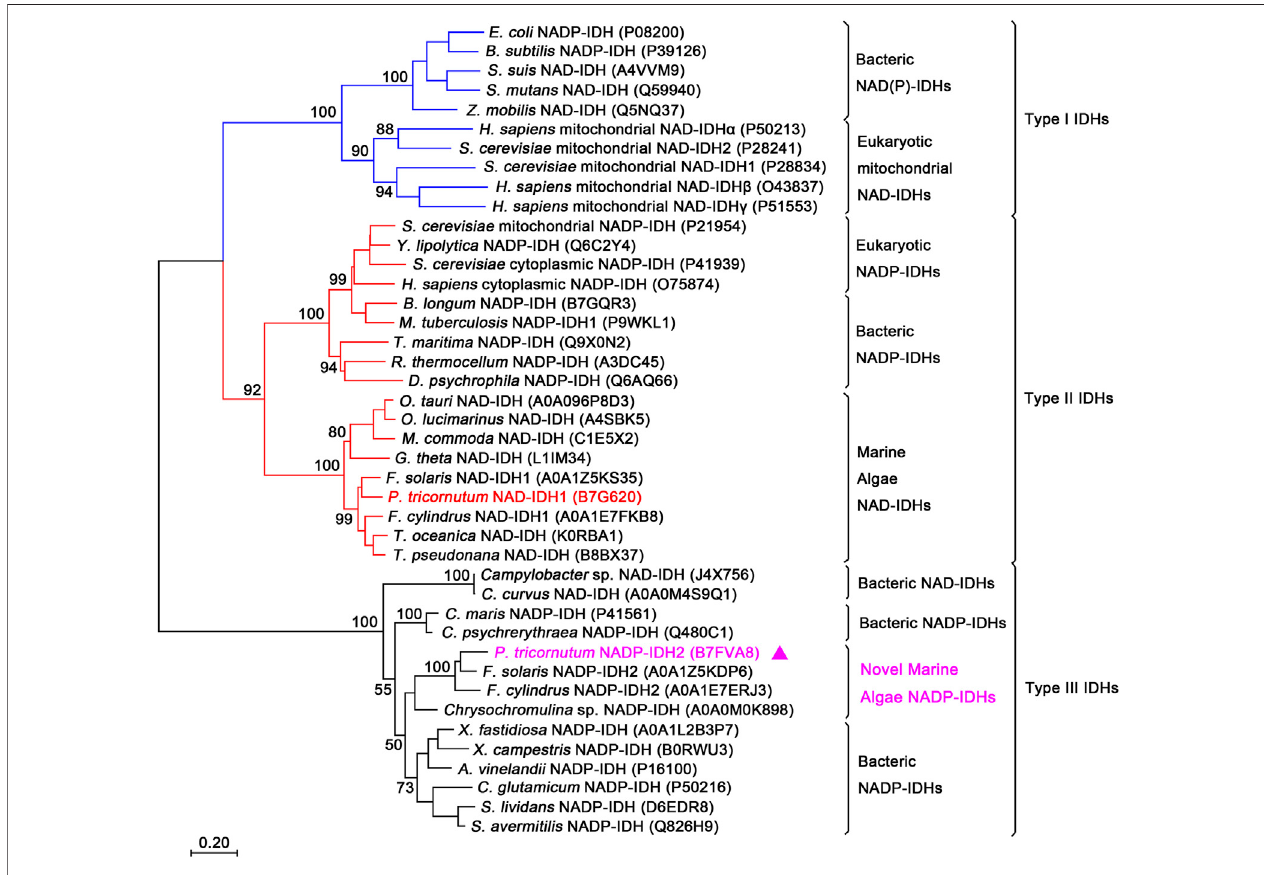
FIGURE1| Phylogeneticanalysisoftheisocitratedehydrogenase(IDH)protein family.Theanalysisincluded 42IDHsequences. Aneighbor-joiningtreewith1,000 bootstrap replicates was constructed using MEGA7. The UniProt entry IDs of all the IDHs are noted in parentheses. PtIDH2 is represented by triangles.